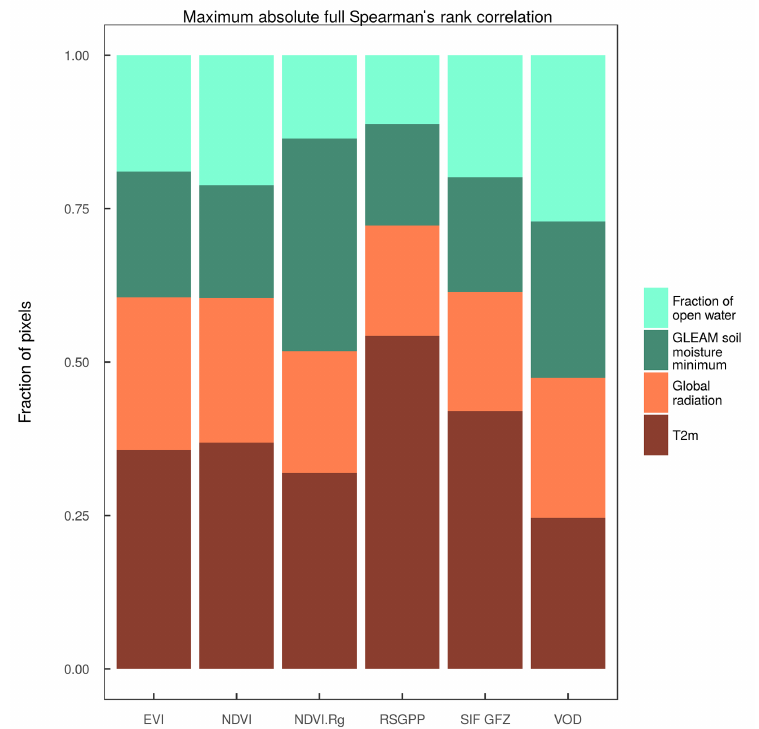
Figure 7. Frequency distribution of the pixel-wise Spearman’s rank correlation between the peak DOY of the vegetation proxies across years and the peak DOY of environmental variables in spatial moving windows of 1.5 ◦ (9 spatial pixels times 10 years at most, correlated only if more than 20 data points available). Plotted here is the variable with the highest absolute correlation without the filter for statistical significance. Full correlations have been calculated (no partial